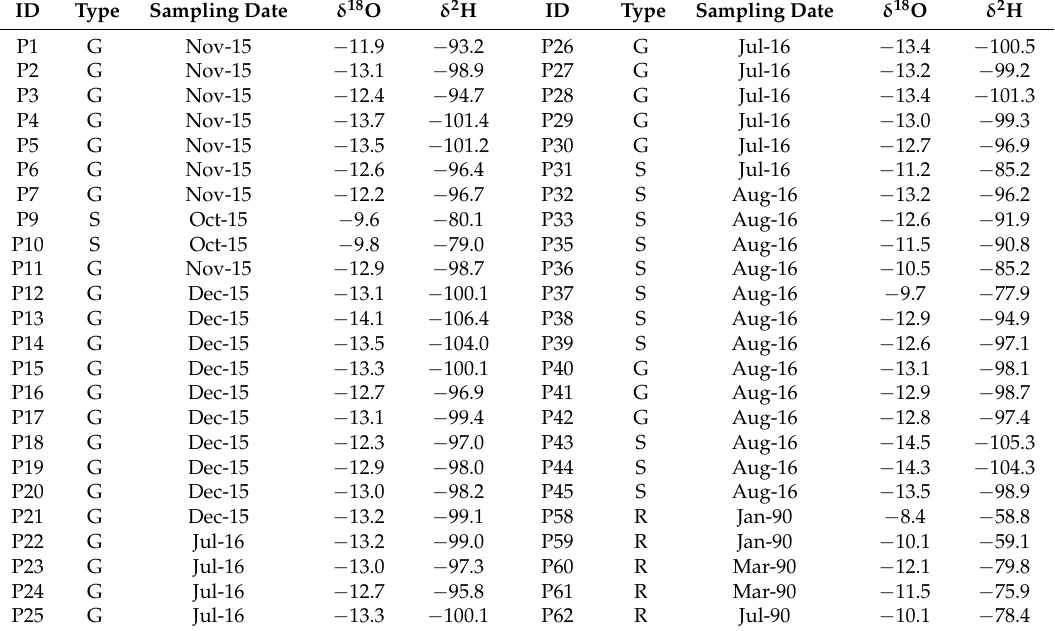
Table 1. δ 18 O and δ 2 H both in ‰ versus Vienna Standard Mean Ocean Water (VSMOW). The letters G, R, and S in the field Type stands for groundwater, rainfall, and surface water, respectively. R type samples are for comparison from Stimson, Frape, Drimmie and Rudolph